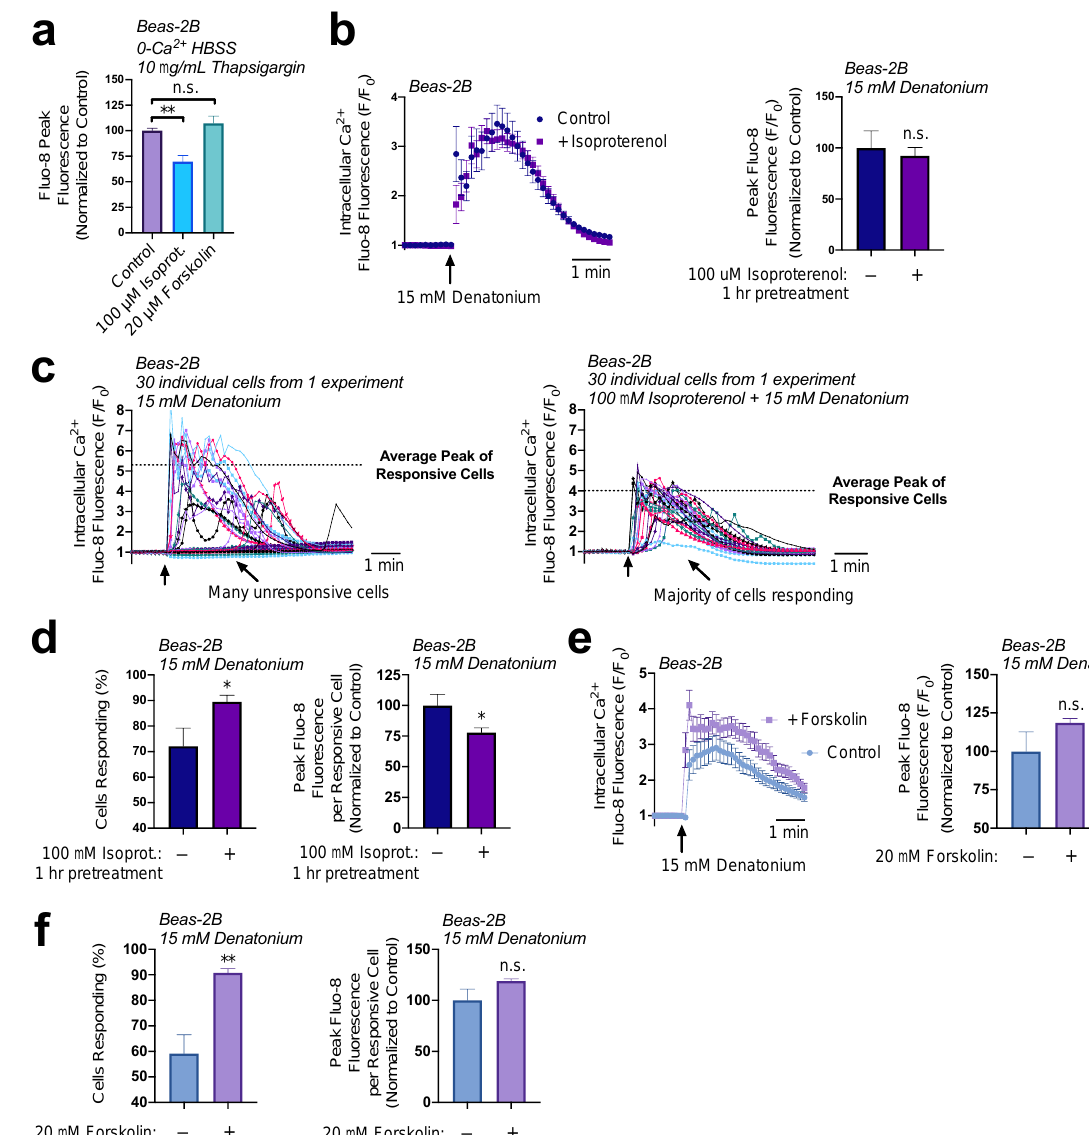
Figure 4. cAMP increases cell responsiveness to denatonium. ( a ) A 1 h preincubation with isoproterenol (100 µM) decreased ER calcium by 30% while forskolin treatment (20 µM) had no significant effect on total ER Ca 2+ . ( b ) A 1 h preincubation with isoproterenol (100 µM) had no effect on the average denatonium-induced Ca 2+ response relative to untreated samples. ( c ) A closer look at individual cell responses from a representative experiment from ( b ) revealed differences in the number of responsive cells and in the average peak Ca 2+ of the responsive cells. ( d ) Re-analysis of data from ( b , c ) showed that isoproterenol pretreatment (1 h, 100 µM), increased the number of cells responsive to denatonium (15 mM) but decreased peak Ca 2+ release per cell by 25%. ( e ) Experiments were carried out as in ( b ) but with adenylyl cyclase activator forskolin instead of isoproterenol, with no significant effect on the peak population Ca 2+ response. ( f ) Like isoproterenol, forskolin increased the percentage of cells responding to denatonium (left graph) but did not significantly affect the peak response per cell (right graph). All traces are representative of ≥ 3 experiments. Bar graphs show mean ± SEM from ≥ 3 experiments. Bar graphs with only 2 data points were analyzed by t -test, bar graphs of >2 data points analyzed by ANOVA using Tukey’s post-test for multiple comparisons: * p < 0.05, ** p < 0.01, “n.s.” represents no